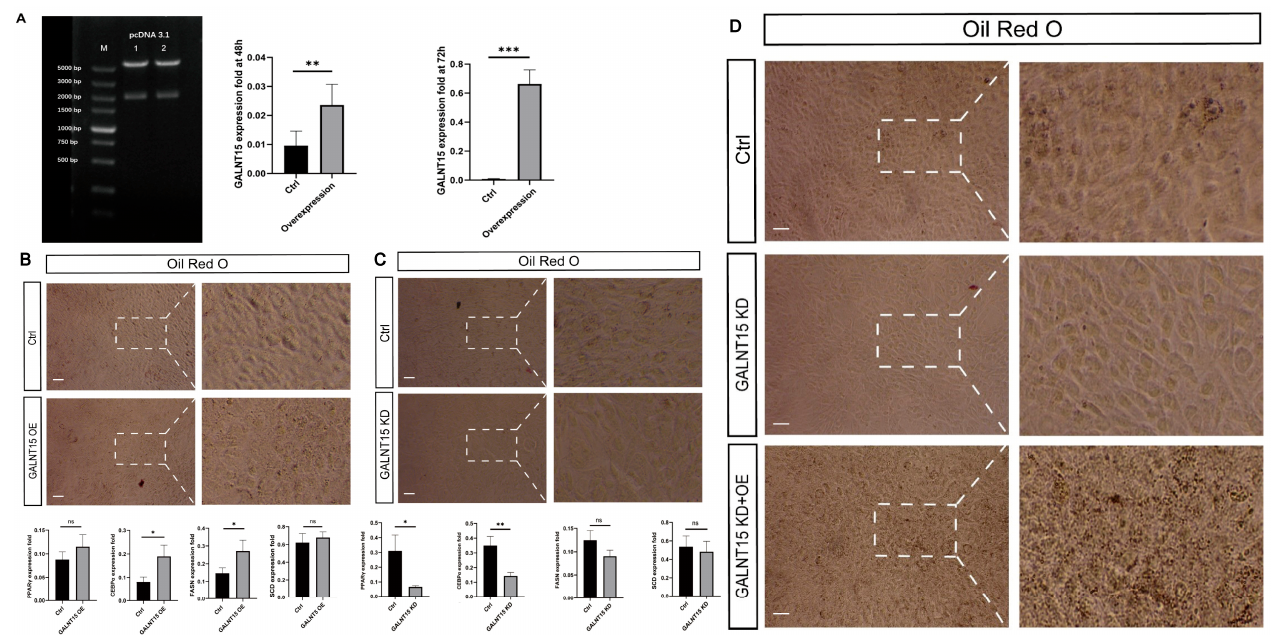
Figure 8. GALNT15 promotes adipogenesis in 3T3-L1 cells. ( A ) Double enzyme digestion verification of GALNT15 overexpression plasmid. M: DNA marker. Lines 1 and 2: two replicates of pcDNA3.1(+)- GALNT15 plasmid. ( B ) Representative images of ORO staining in 3T3-L1 cells treated with control (Ctrl) or GALNT15 OE for 48 h (Scale bars, 100 µ m). n = 3 biological samples. RT-qPCR analysis of GALNT15 OE for adipogenic marker genes. ( C ) Representative images of ORO staining in 3T3-L1 cells treated with Ctrl or GALNT15 KD for 48 h (Scale bars, 100 µ m). n = 3 biological samples. RT-qPCR analysis of GALNT15 KD for adipogenic marker genes. ( D ) Representative images of ORO staining in 3T3-L1 cells treated with Ctrl, GALNT15 KD and GALNT15 KD+OE. n = 3 biological samples. Error Bar indicated SEM, * p < 0.05, ** p < 0.01, *** p < 0.001. ns, not